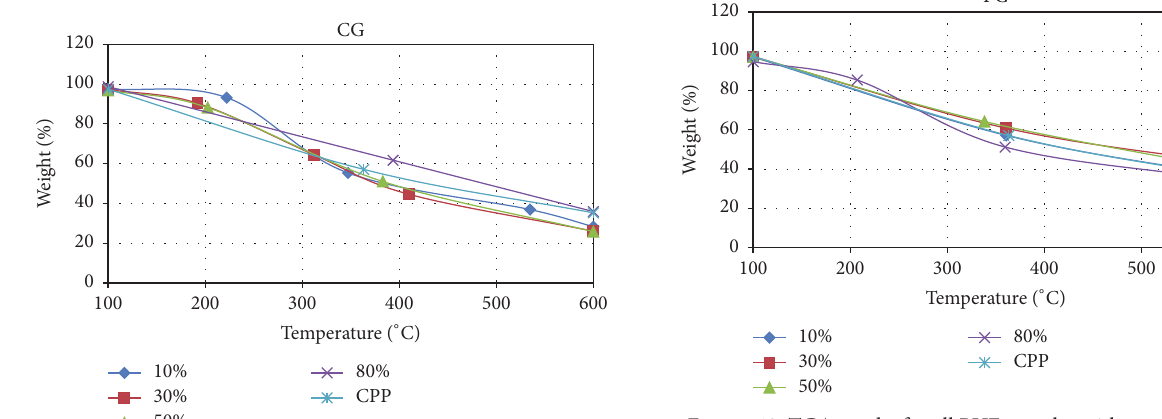
Figure 10: TGA results for all PUF samples with pure